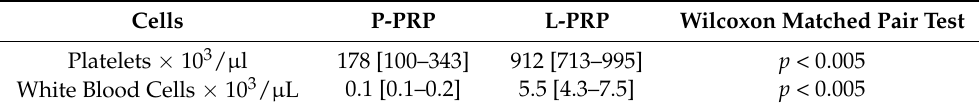
Table 1. Platelet-rich plasma preparations: cell concentration.